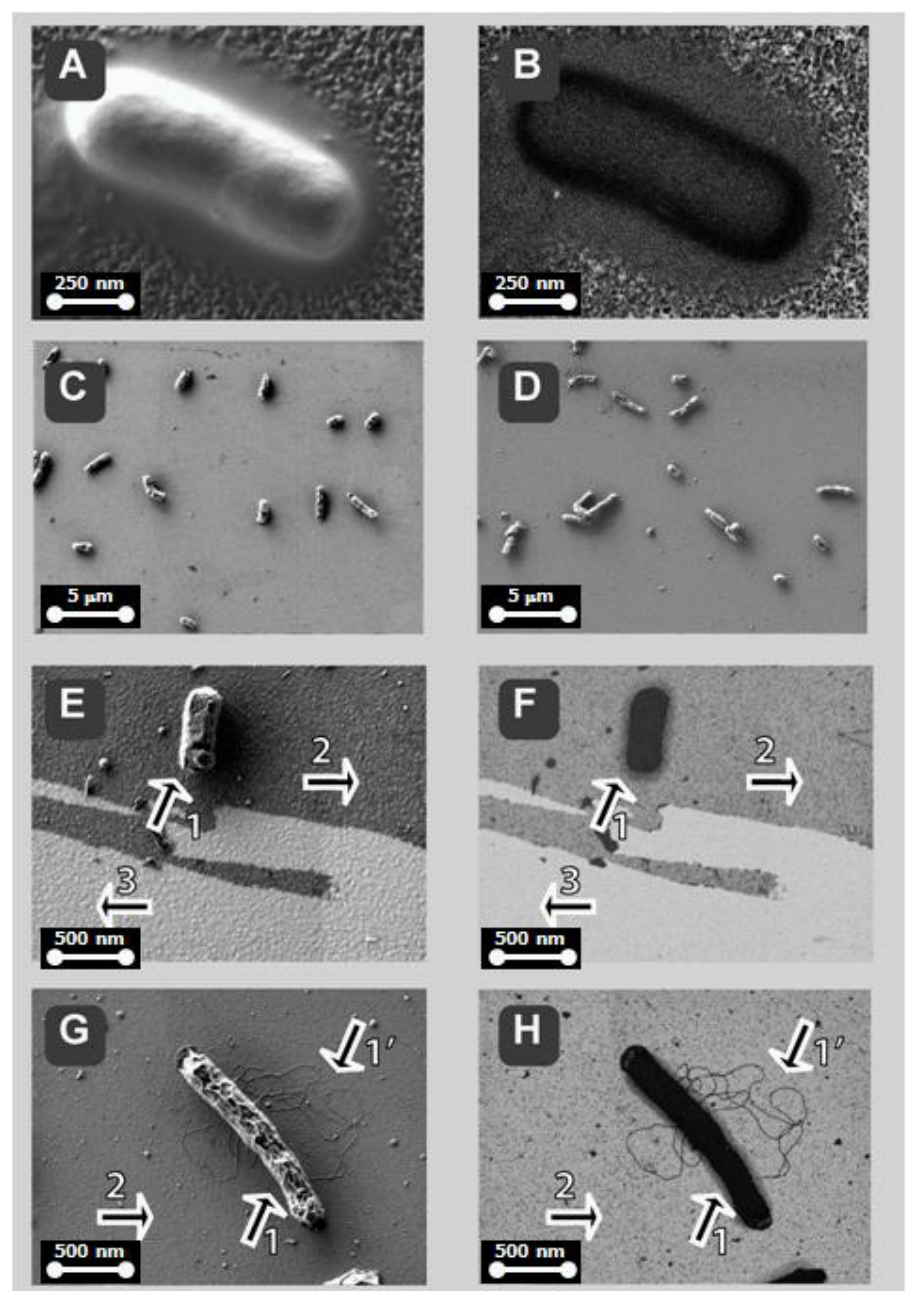
Figure 8. Functionalized biosensors for bacteria Escherichia coli of silicon chip metalized with titanium, gold, or ruthenium, visualized by scanning electron microscopy, SEM. The bacteria binding to functionalized Ti is shown in ( A , B ) as a result of specific interaction bacteria Escherichia coli and antibody anti- Escherichia coli . The surface of the functionalized sensor metallized with gold ( C ) versus ruthenium ( D ) shows the efficient binding of the bacterium Escherichia coli , at comparable efficacy for both metals. Enlarged images of bacteria bound to Au are shown in ( E , F ) or to Ru in ( G , H ). The topography/texture imaging was correlated to chemical contrast maps, shown in image pairs A <=> B, E <=> F, and G <=> H, with pixel-to-pixel accuracy. Advantages of correlative imaging clarify fine detail structures such as flagella of bacterium on functionalized ruthenium in Figure 8G <=> H (arrow 1’). Correlative imaging becomes particularly helpful when thin surface coatings (arrow 2) are to be distinguished from bare metallized-substratum (arrow 3), as shown in image pairs in Figure 8E <=> F and in Figure 7 E <=> F.